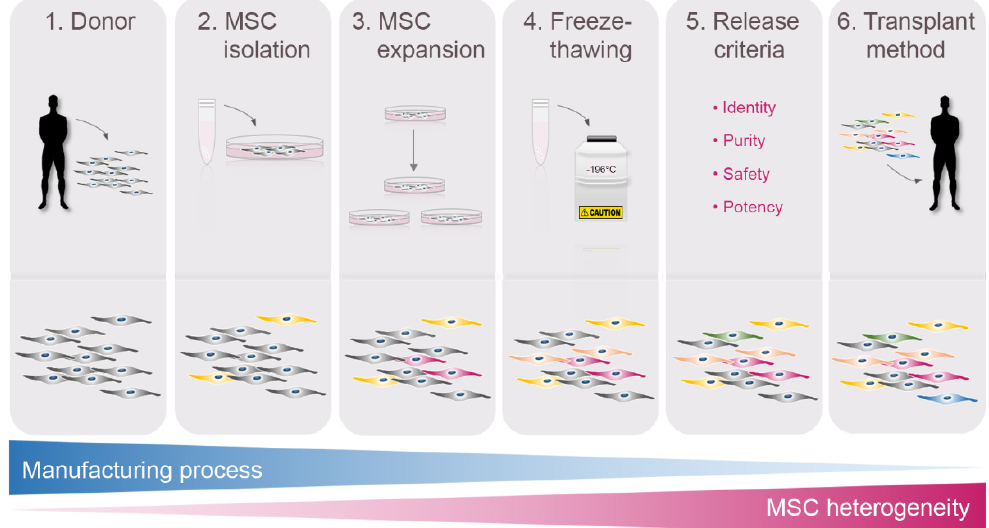
Figure 1. Acquisition of heterogeneity during the manufacturing process of MSCs. MSC heterogeneity increases over the manufacturing process due to multiple factors, such as the particular characteristics of the donor, the isolation method, the conditions of the culture, the freeze-thawing procedure, the release criteria for therapeutic application and the method of administration.